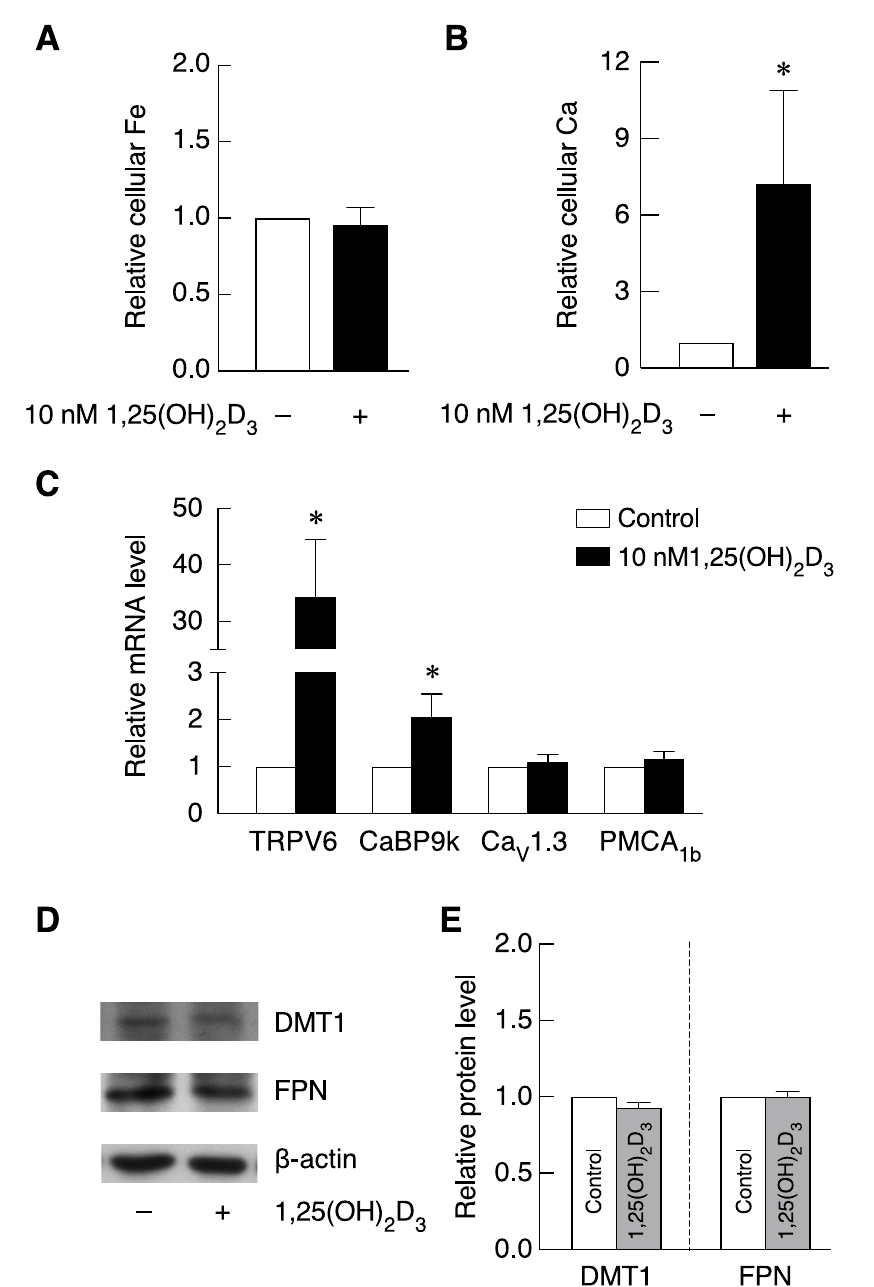
Fig 4. 1,25(OH) 2 D 3 strongly increased cellular calcium uptake and the expression of calcium transporter and calcium binding protein; however, it had no effect on cellular iron uptake nor iron transporter level in Caco-2 cells. ( A ) Cellular iron and ( B ) cellular calcium in Caco-2 cells of same sample groups were measured by FAAS after being treated with 1,25(OH) 2 D 3 for 72 hours (n = 3). ( C ) mRNA expression of calcium transporter as well as calcium binding protein in Caco-2 cells was investigated after being exposed to 10 nM 1,25(OH) 2 D 3 for 72 hours (n = 4). ( D ) DMT1 and FPN protein expression was determined by western blot ( E ) The quantitative data of protein band intensity as normalized by β -actin and control groups were analyzed by Image J (n = 3). Data was analyzed from at least three independent biological experiments as indicated (n). P -value was calculated using one-tailed Mann-Whitney U Test. � P < 0.05 as compared to control group.